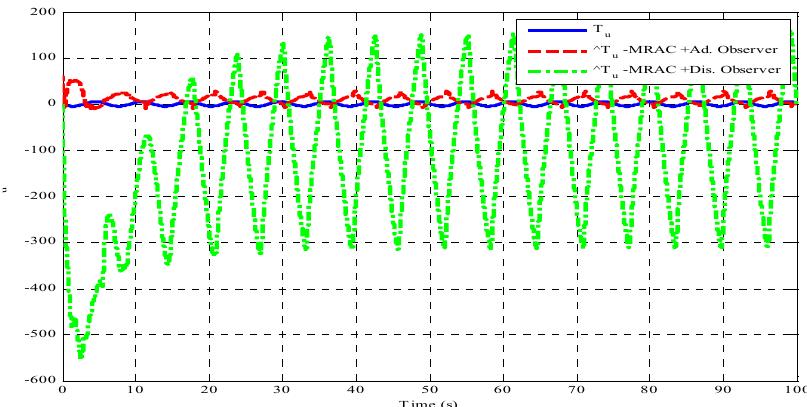
Figure 9. Disturbance estimations based on the three controllers.